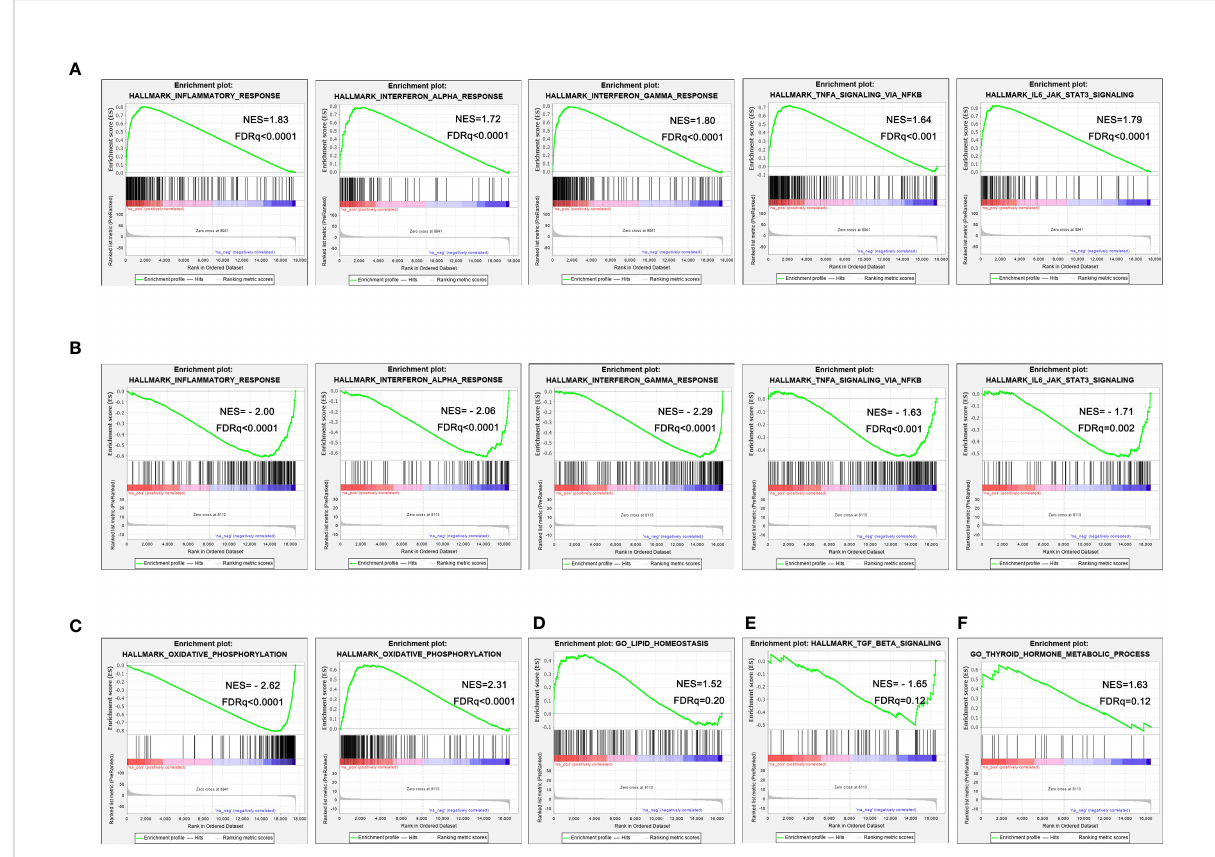
FIGURE 4 Aerobic exercised NASH mice display improved hepatic in fl ammation by RNA-seq. (A) Representative enrichment plots of important pathways enriched in the liver of NASH mice. (B) Representative enrichment plots of important pathways enriched in the liver of NASH+exercise mice. (C) Enrichment plots of oxidative phosphorylation signaling pathway enriched in the liver of NASH mice (left) and NASH+exercise mice (right). (D) Enrichment plots of lipid homeostasis signaling pathway enriched in the liver of NASH+exercise mice. (E) Enrichment plots of fi brosis-related pathway enriched in the liver of NASH+exercise mice. (F) Enrichment plots of thyroid hormone metabolic process signaling pathway enriched in the liver of NASH+exercise